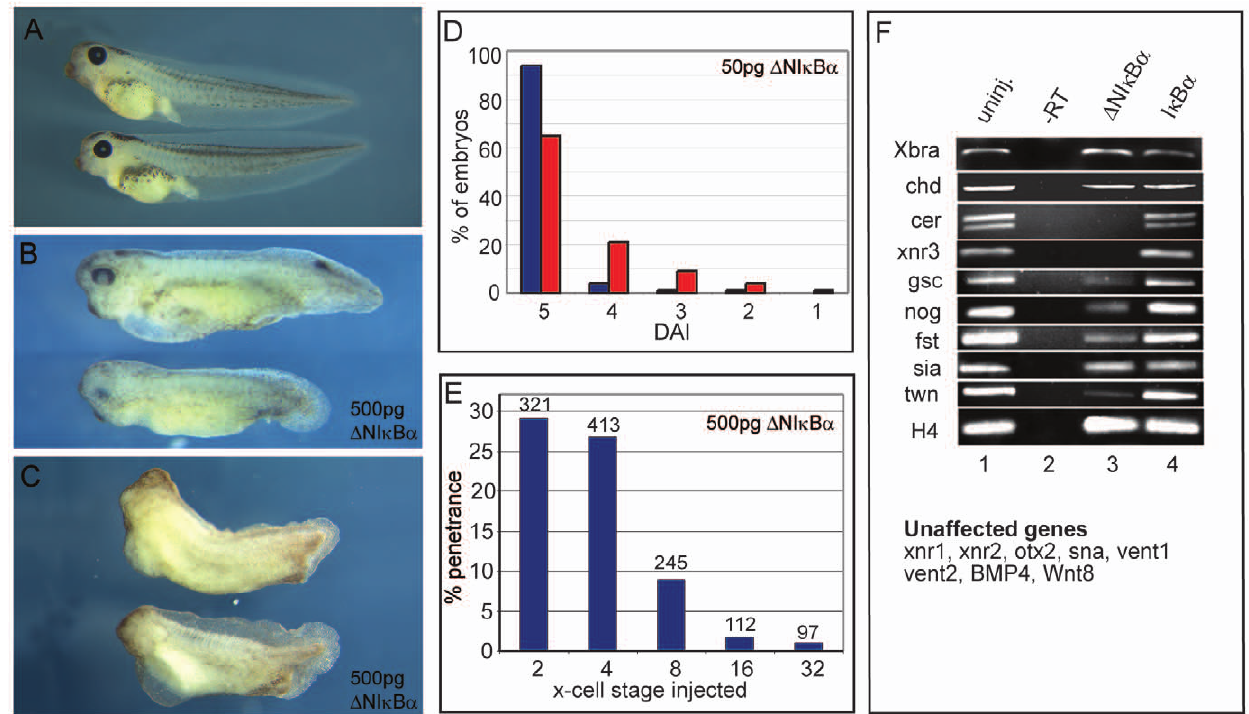
Figure 1. NF- k B activity is required for head formation. A ) Wild type embryos at stage 40/41. B, C ) Sibling embryos injected sub-equatorially on the dorsal side with 500 pg of D NI k B a RNA at the 4-cell stage show pleiomorphic phenotypes: B) Mild phenotypes (DAI 4) are characterized by reduction in forebrain and eyes. C) Stronger phenotypes (DAI 3) show reduced head and dorsal structures. ( D ) Graphical representation of dorsoanterior index (DAI) of control embryos (blue columns) versus embryos injected dorsally with 50 pg of D NI k B a (red columns). ( E ) Time course analysis of embryos injected dorsally with a total of 500 pg D NI k B a RNA at the two, four, eight, 16- and 32-cell stage; the accompanying decrease in cell size was compensated by injecting multiple dorsal cells from the 8-cell stage on (see materials and methods). Y-axis represents the percentage of embryos with anterior truncations. ( F ) Semi-quantitative RT-PCR analysis for marker genes in stage 10 marginal zone explants. Lane 1: uninjected embryos; lane 2: minus reverse transcriptase control; lane 3: 500 pg D NI k B a RNA injected dorsally; lane 4: 500 pg wildtype I k B a RNA injected